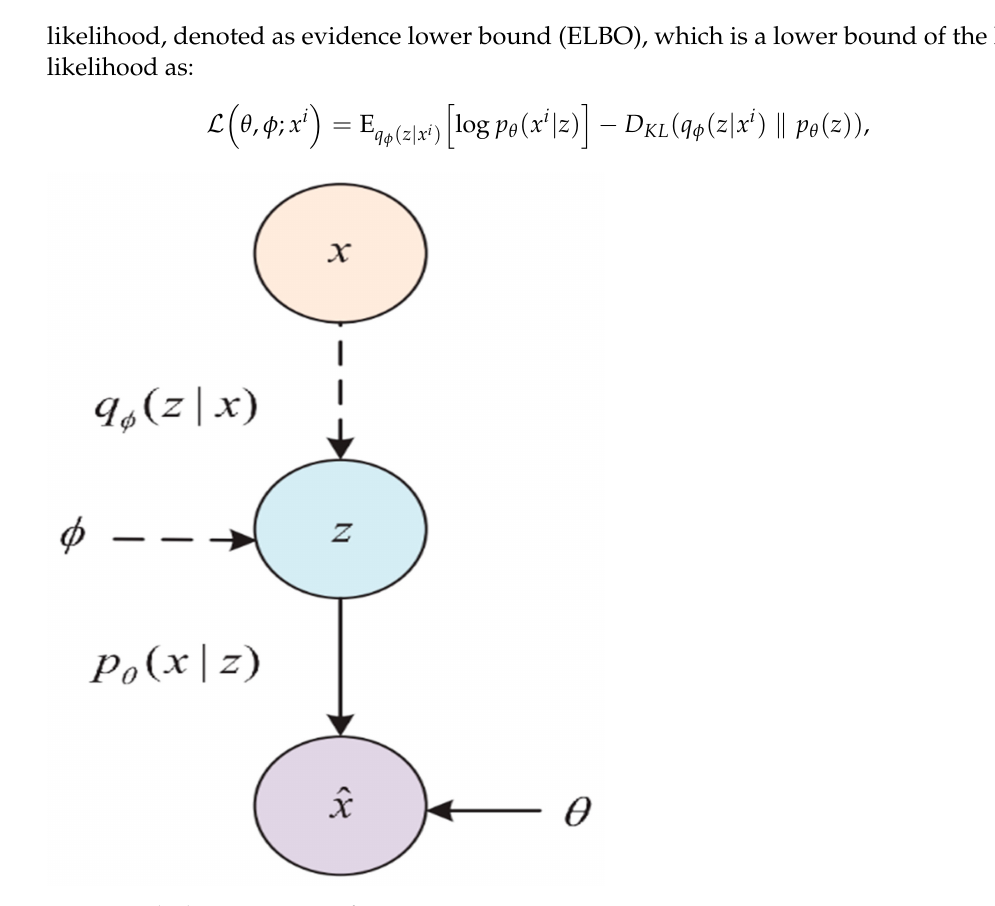
Figure 1. The basic structure of